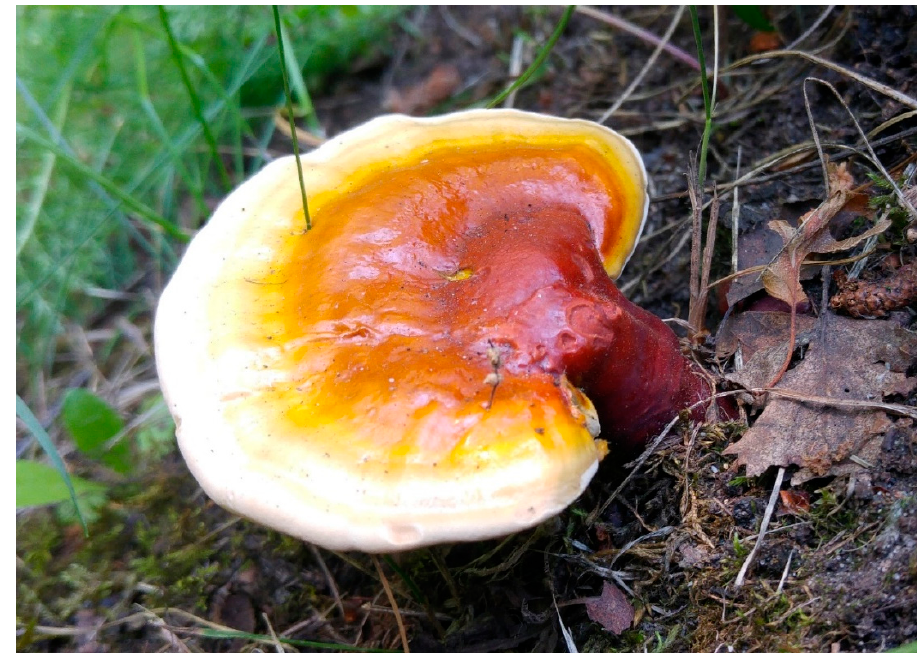
Figure 3. Ganoderma lucidum in its natural habitat (photo by Pawe ł Stasiowski).